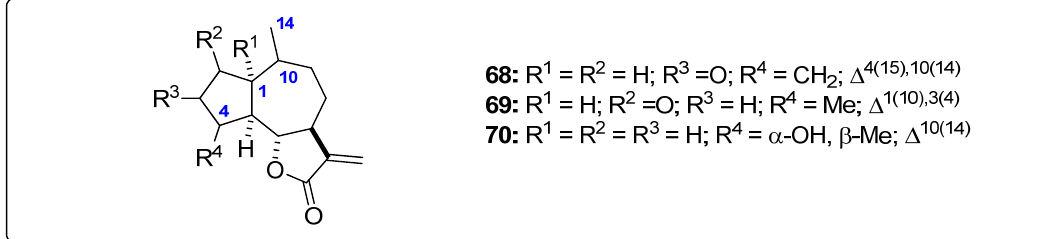
Figure 5. Structures of the tested guaianolide sesquiterpenes [26,28,29].